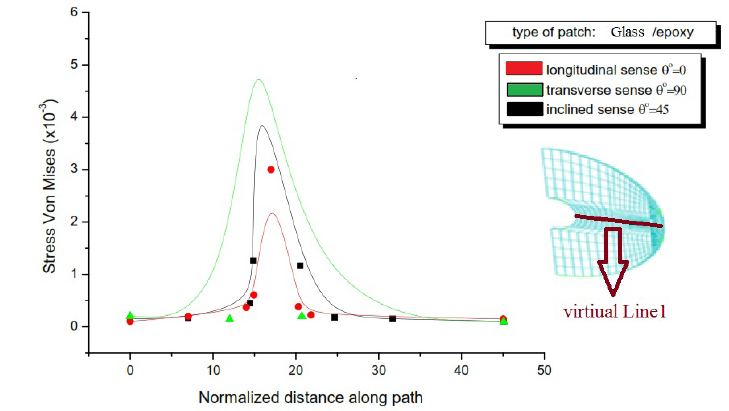
Figure 8. Distribution of σxx stresses for a cracked plate.